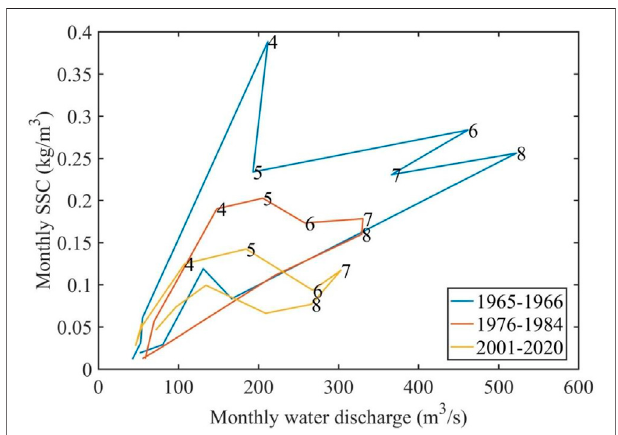
FIGURE 8 | Ratio curve of the monthly SSC and monthly water discharge (the number indicates the month).